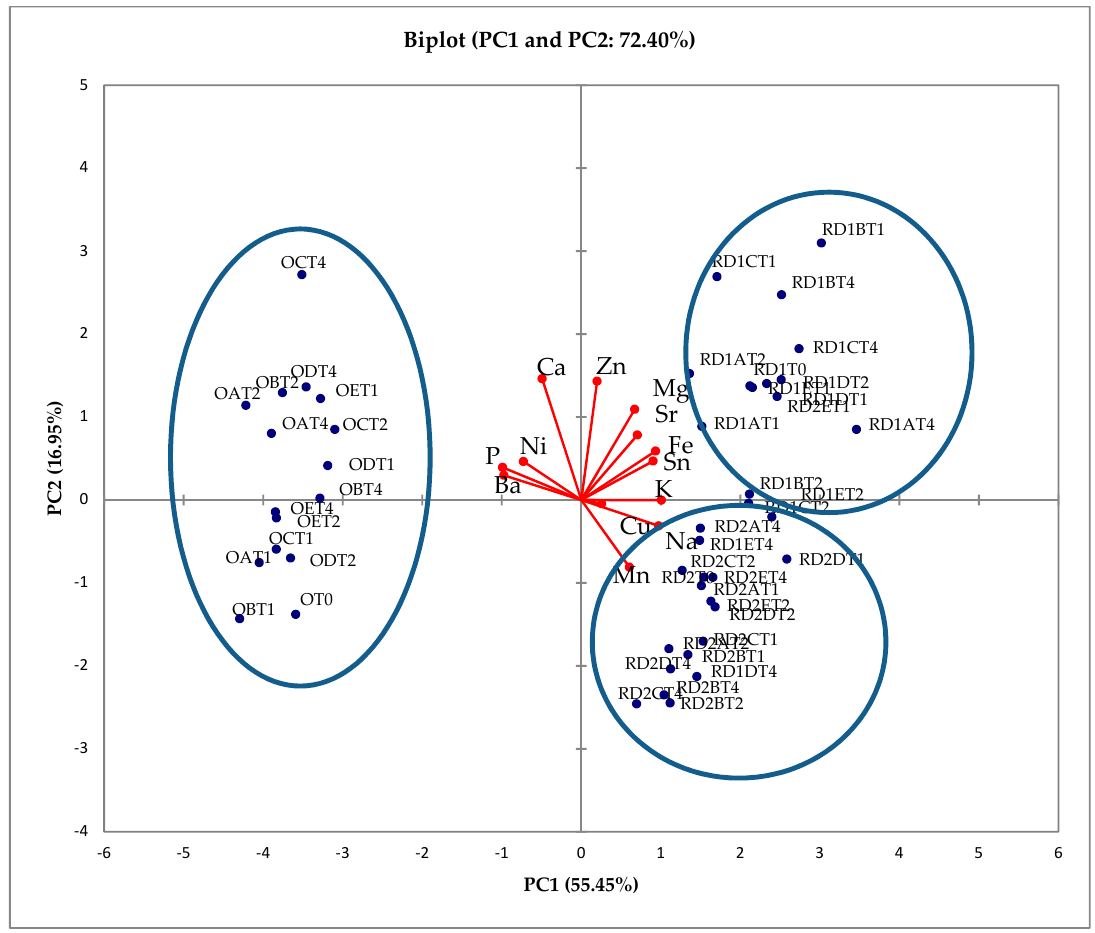
Figure 3. Biplot obtained by principle component analysis (PCA) (PC1 vs. PC2) on the whole dataset.